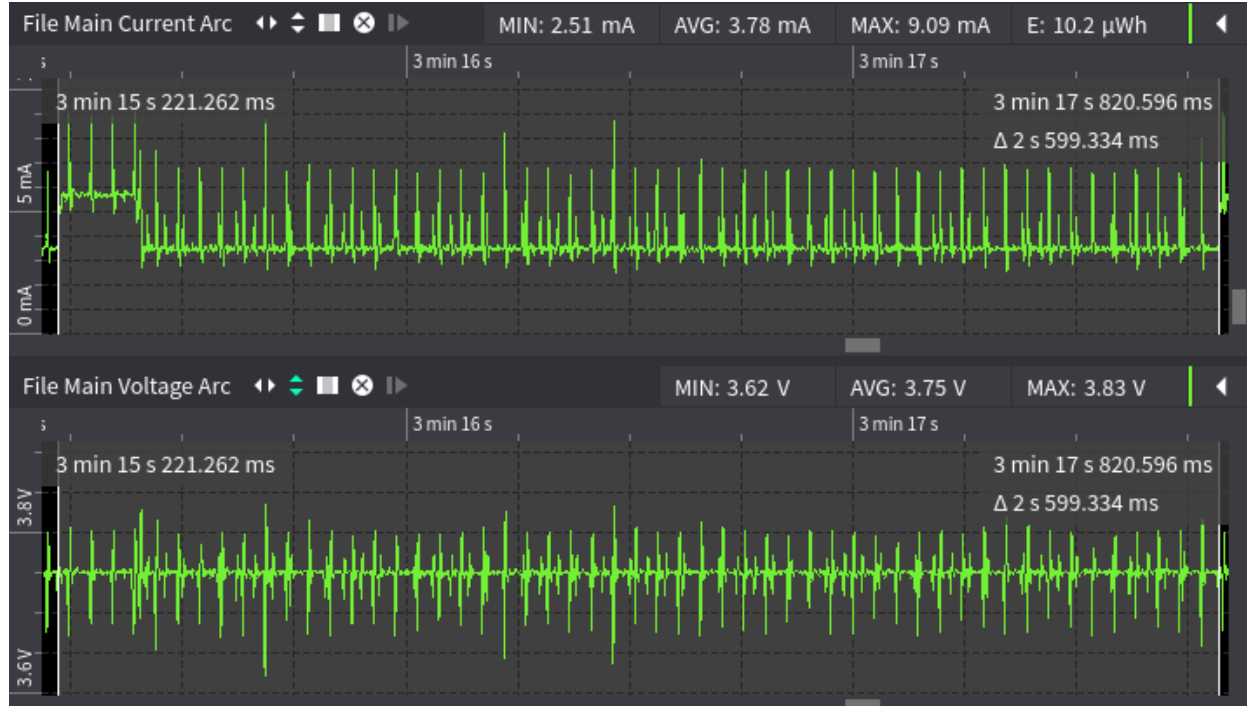
Figure 9. Current and voltage captures over one inference period by Qoitech Otii software for int16 model with 48 filters per convolution and CMSIS-NN optimizations